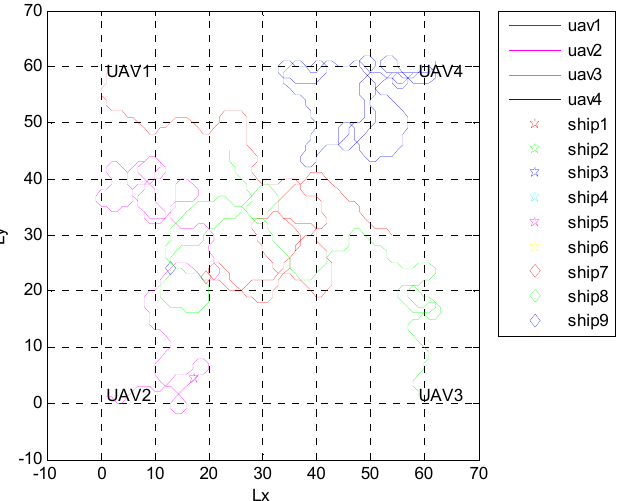
Figure 7. The initial stage of the v-shaped formation search.